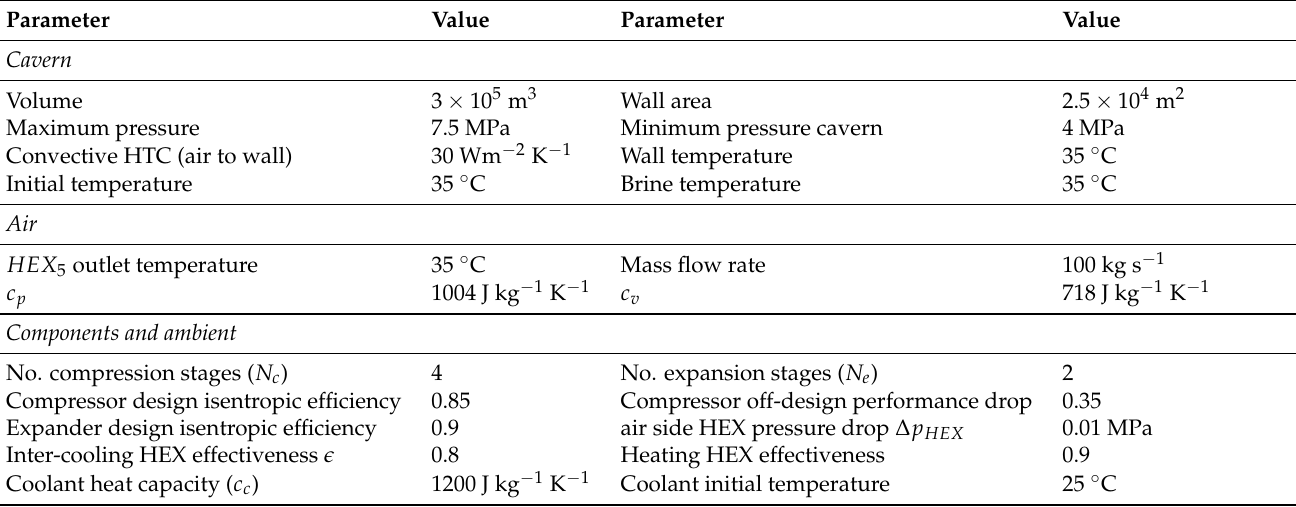
Table 1. Key model